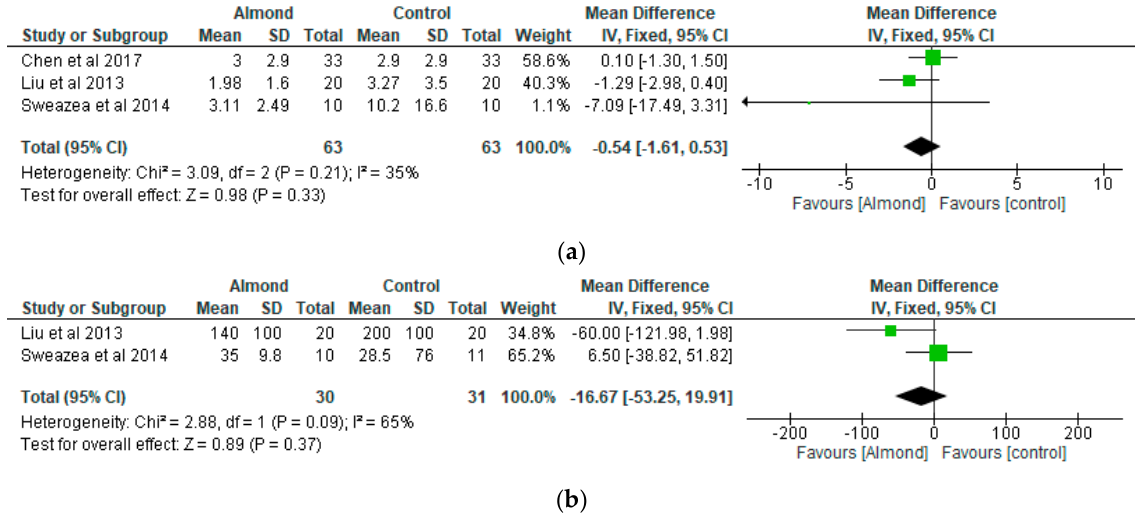
Figure 4. The effect of almonds on ( a ) C-reactive protein (mg/L) and ( b ) tumour necrosis factor– α (pg/mL).